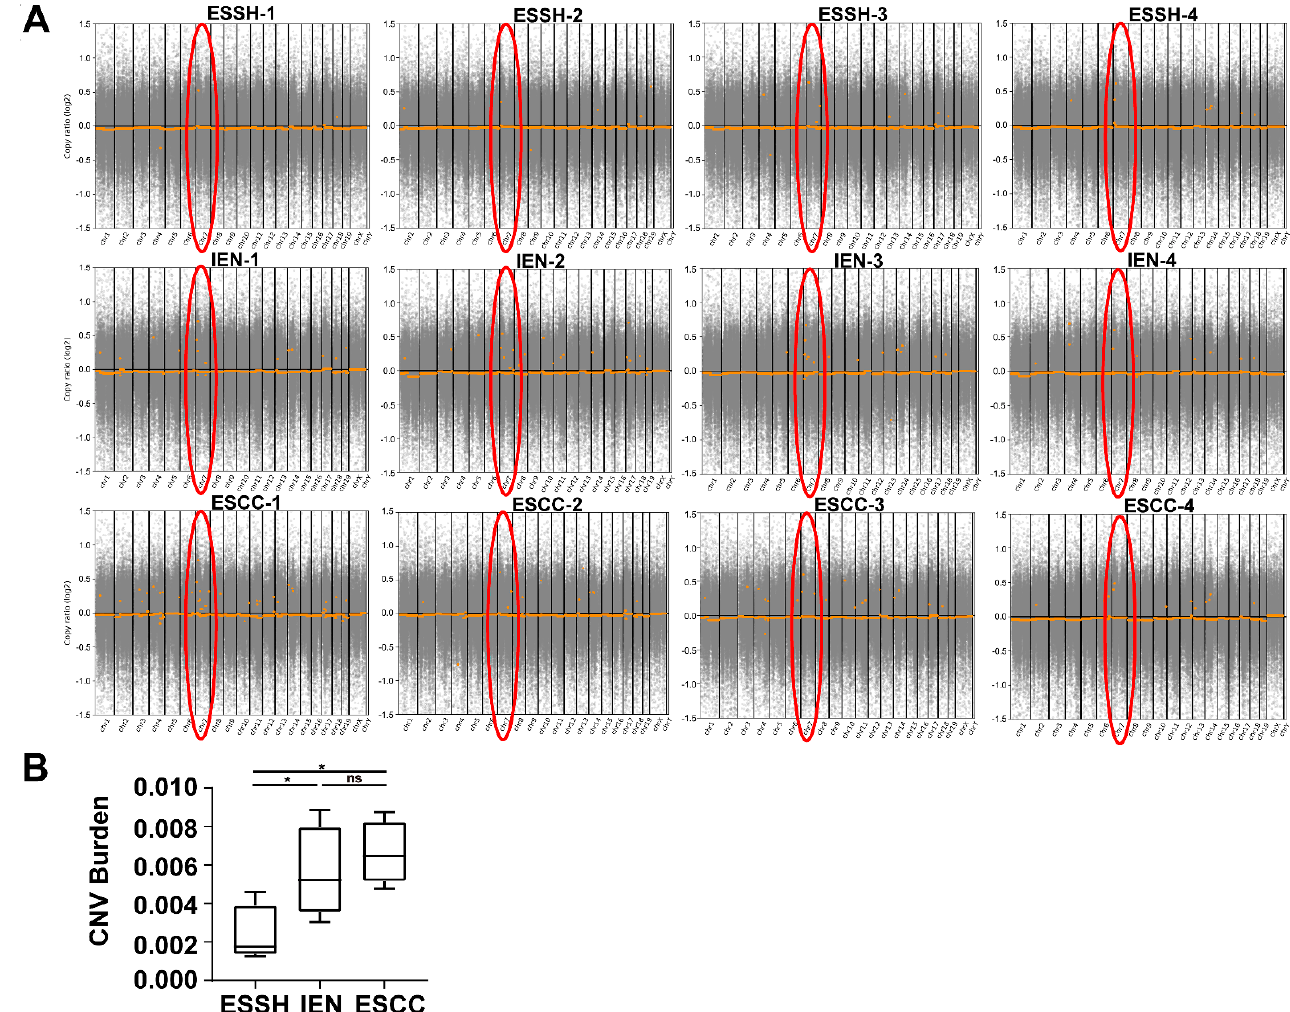
Figure 4. CNVs in different stages of ESCC mice model. ( A ) CNVs in chromosomes 1–19. The marked red circles indicate CNVs on chromosome 7 in each sample detected by WES. ( B ) CNV burden at different pathological stages (* p < 0.05, ESSH vs. IEN ESCC stage, ns p > 0.05 IEN vs. ESCC stage).